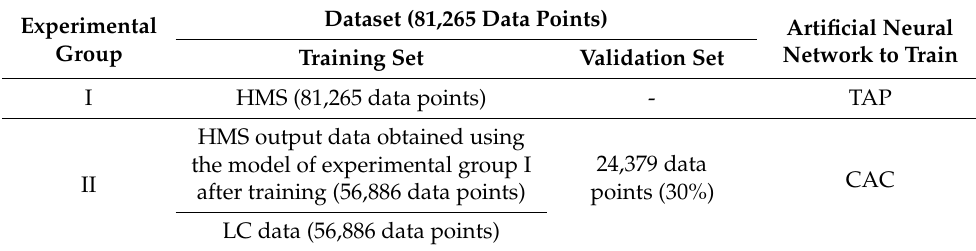
Dataset (81,265 Data